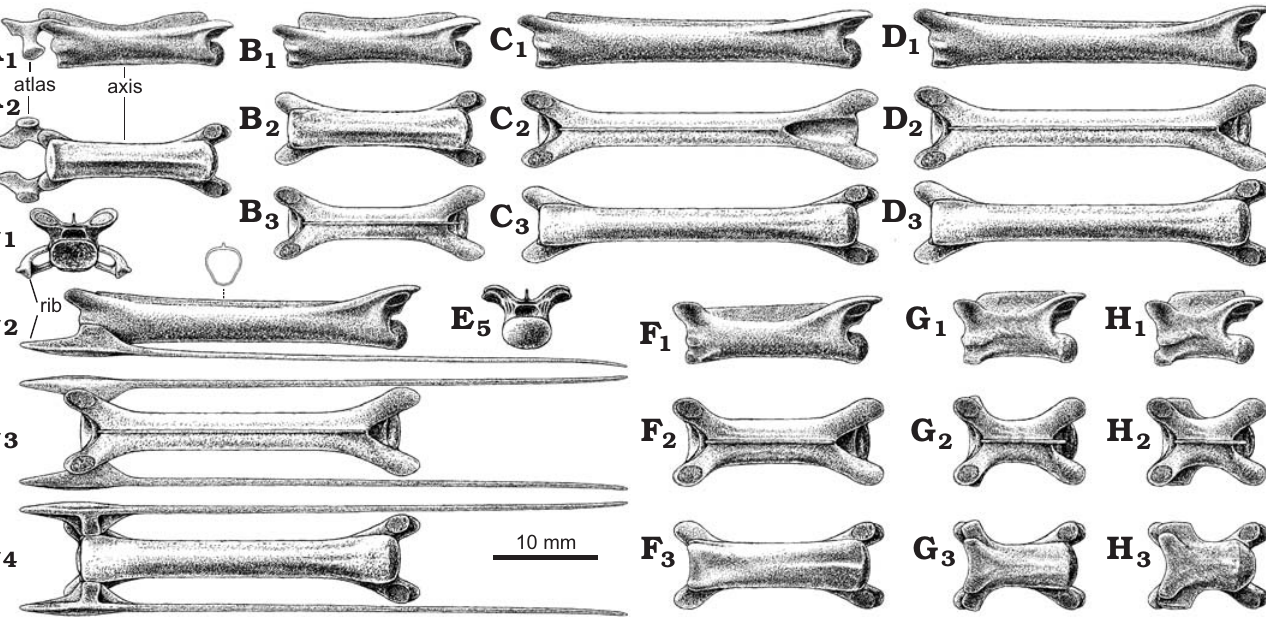
Fig. 9. Restoration of cervicals of long-necked reptile Ozimek volans gen. et sp. nov. A . Neural arches of atlas and complete axis, ZPAL AbIII/3191. B . Cervical 3, ZPAL AbIII/2051. C . Cervical 4, ZPAL AbIII/2511. D . Cervical 5, UOPB 1148. E . Cervical 6 with ribs, based on UOPB 1148, ZPAL AbIII/2456, /2511, /2512. F . Cervical 7, based on UOPB 1148, ZPAL AbIII/2528, /2494, /2454, /2511. G . Cervical 8, based on UOPB 1148, ZPAL AbIII/2528, /2499, /2511, /2512. H . Cervical 9, based on UOPB 1148 and ZPAL AbIII/2499. In left lateral (A 1 –D 1 , E 2 , F 1 –H 1 ), ventral (A 2 –D 2 , E 3 , F 2 –H 2 ), and dorsal (A 3 –D 3 , E 4 , F 3 –H 3 ), anterior (E 1 ), and posterior (E 5 )